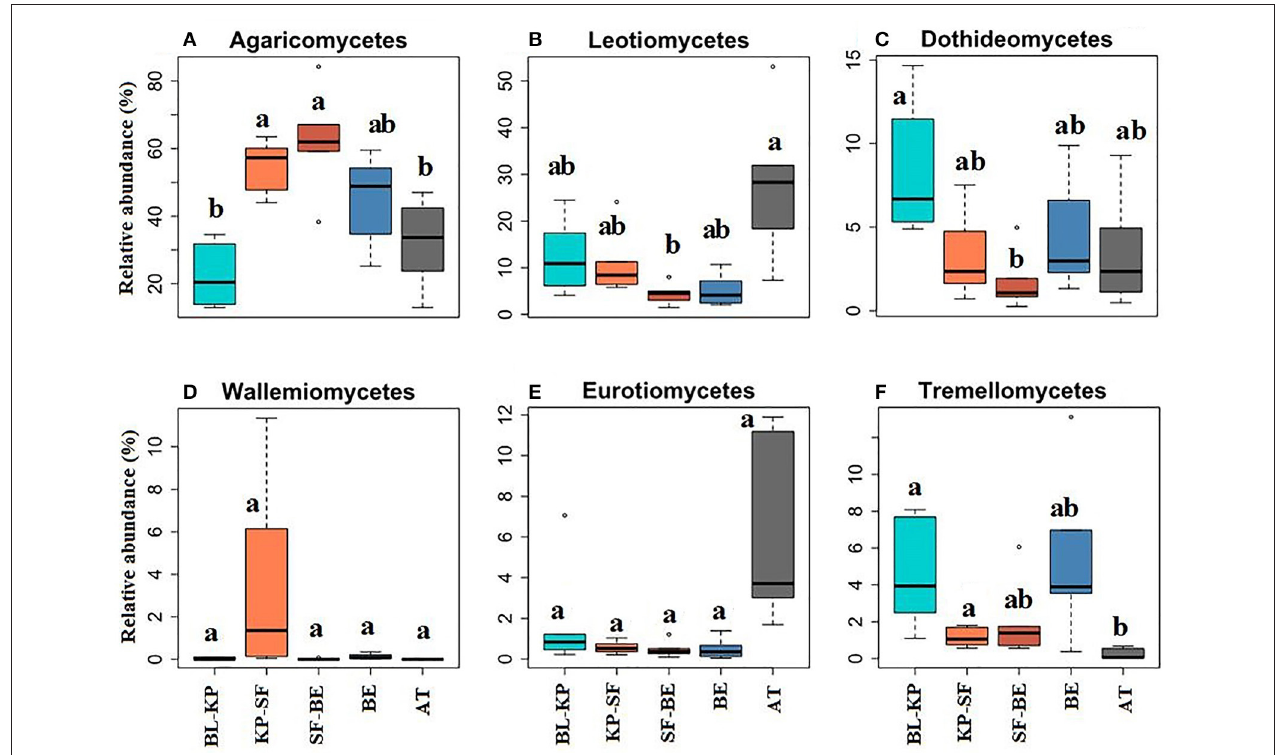
FIGURE 5 | The elevational distribution patterns of the relative abundances of specific fungal classes within the phylum of Basidiomycota and Ascomycota. Agaricomycetes (A) and Wallemiomycetes (D) belong to Basidiomycota, Leotiomycetes (B) , Dothideomycetes (C) , Eurotiomycetes (E) , and Tremellomycetes (F) are classes within Ascomycota. Significantly different ( t -test, P adjust < 0.05) groups are denoted with different letters. BL-KP, Broad leaf-Korean pine mixed forest; KP-SF, Korean pine-spruce fir forest; SF-BE, Spruce Fir- Betula ermanii forest; BE, Betula ermanii forest; AT, Alpine tundra.